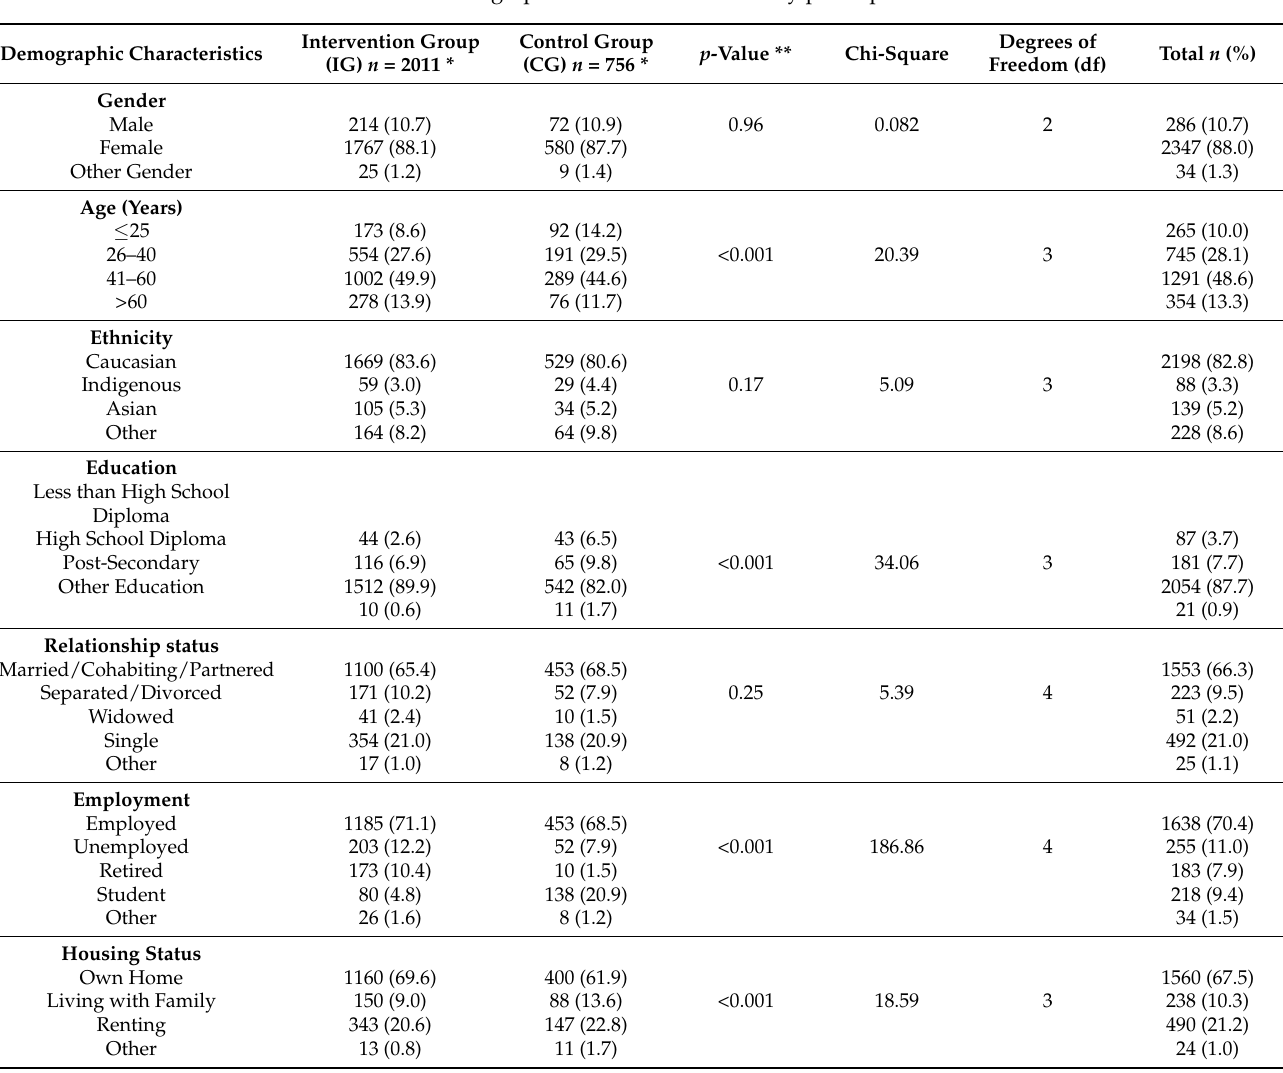
Table 1. Demographic characteristics of study